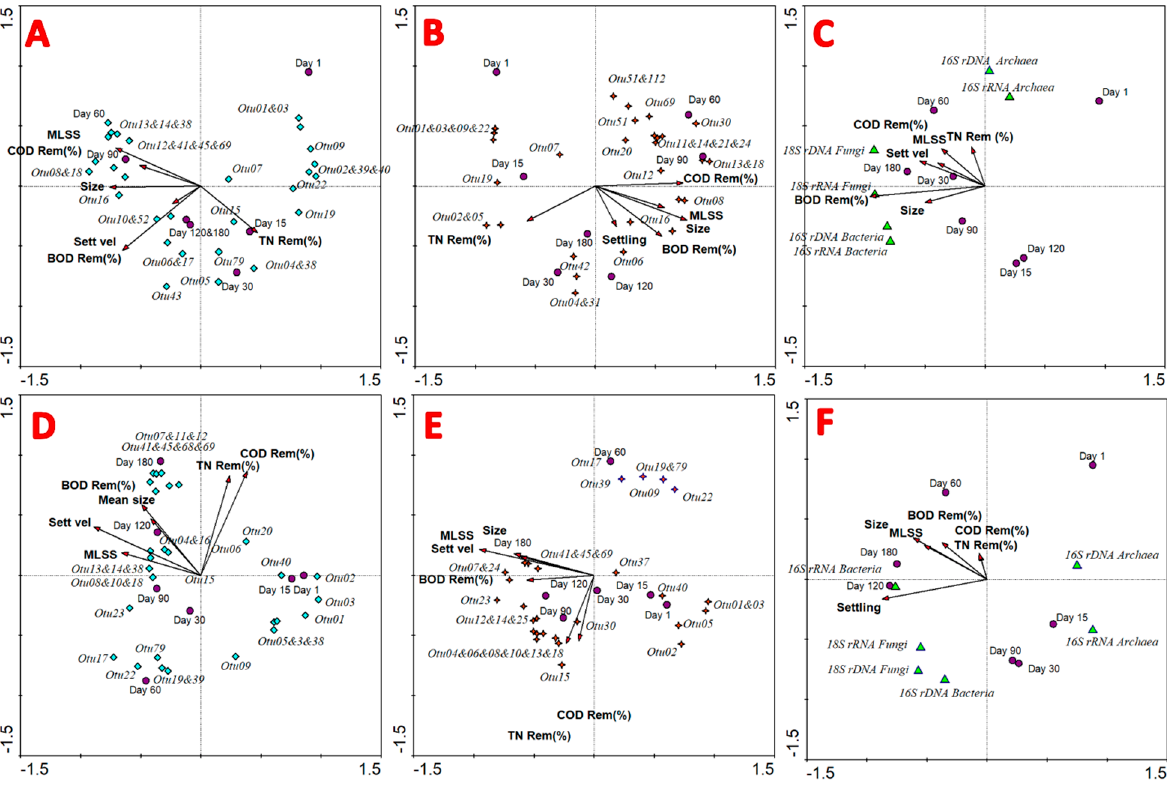
Figure 8. Multivariate redundancy analysis of the most abundant 16S rRNA bacterial genes for CB ( A ) and PB ( D ) with physico-chemical removal ratio (logarithm); multivariate redundancy analysis of the most abundant 16S rRNA bacterial genes for CB ( B ) and PB ( E ) with physico-chemical removal ratio (logarithm); multivariate redundancy analysis of total and metabolically active copies of target genes with physico-chemical performance for CB ( C ) and PB ( F ).